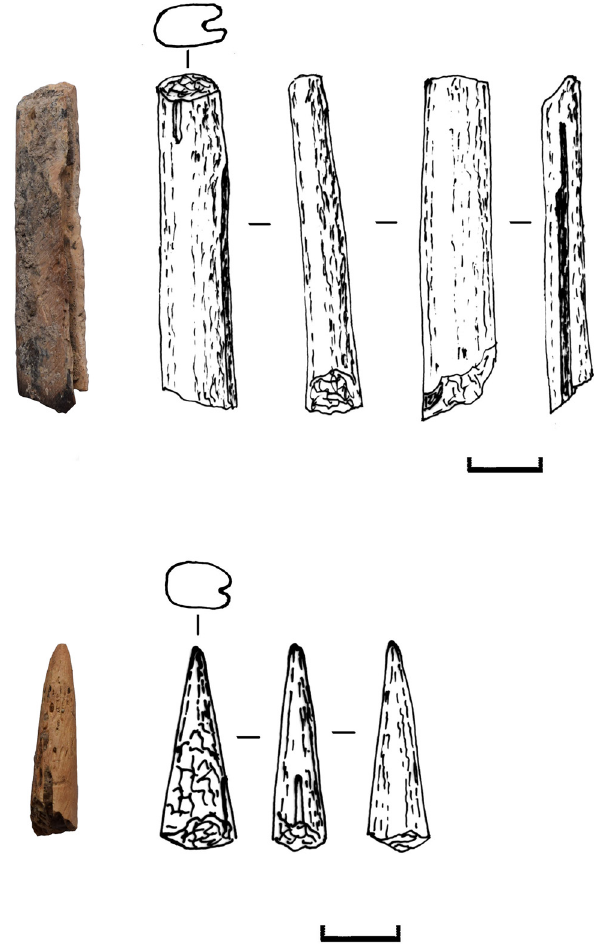
Figure 1: Bone points from the layer B of Kamyana Mohyla 1. Above – 2018, trench 2, sq. 16, z – 90; Below – 2017, trench 2, sq. 17, z –